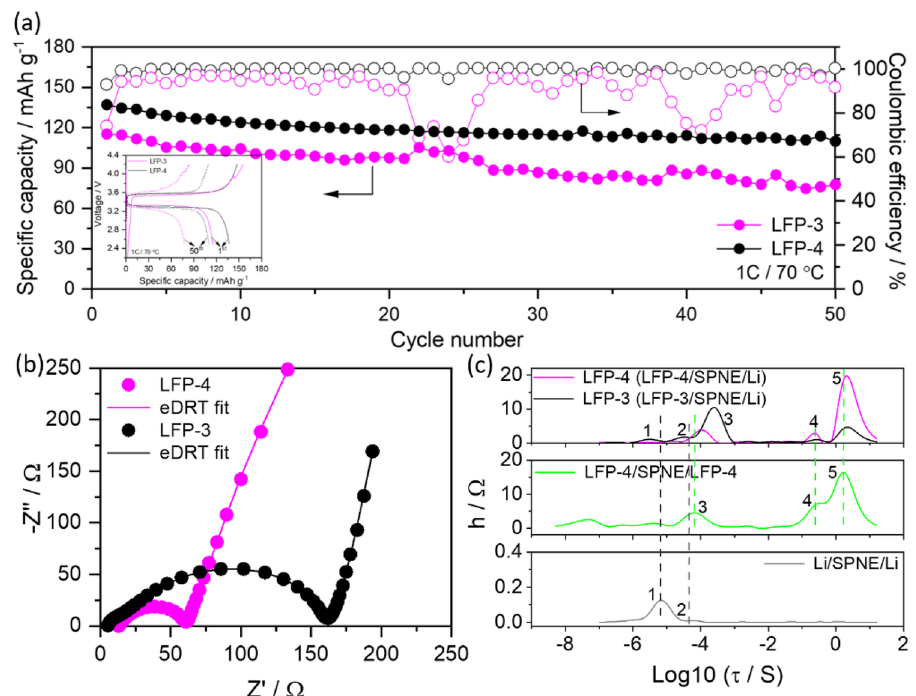
Figure 5. ( a ) Comparative cycle performance curves of Li/SPNE/LFP batteries having LFP-3 and LFP-4 as cathodes measured at 70 °C at 1C rate with inset of their corresponding charge–discharge curves for the 1st and 50th cycles, ( b ) the corresponding Nyquist plots before cycling and ( c ) a comparison of the eDRT time constants curves of the batteries (top) with symmetrical cathode-only cell (middle) and anode-only cells (bottom), all measured at 70